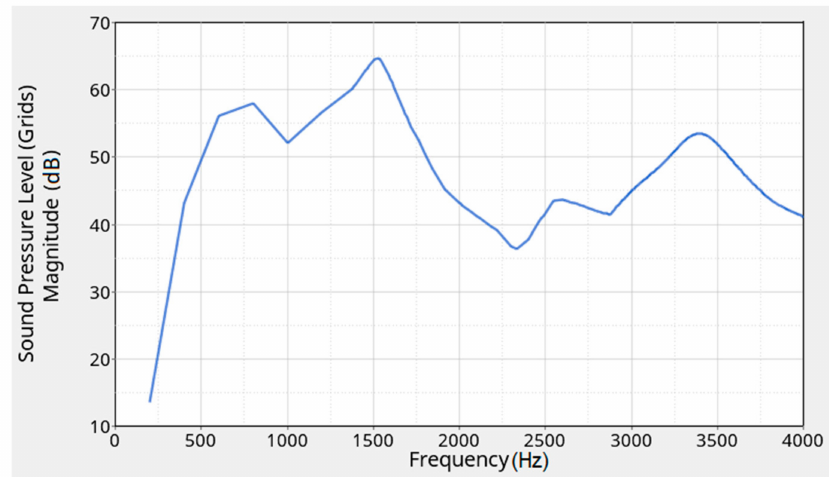
Figure 19. The sound pressure level detected by the red zone’s